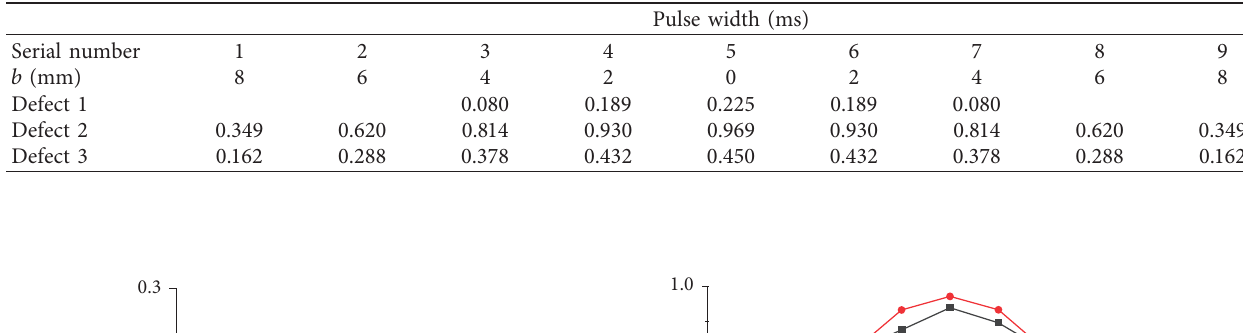
Table 4: Calculated values of tapping response pulse width at different positions in the defective